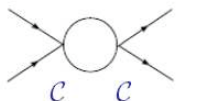
is either the singlet C